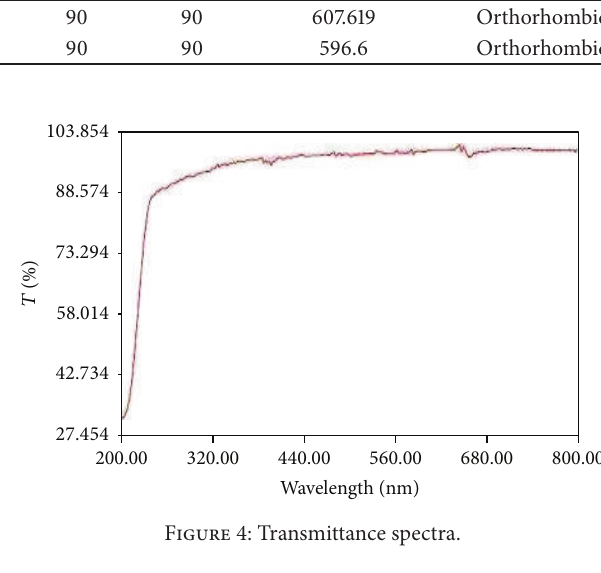
Figure 4: Transmittance spectra.